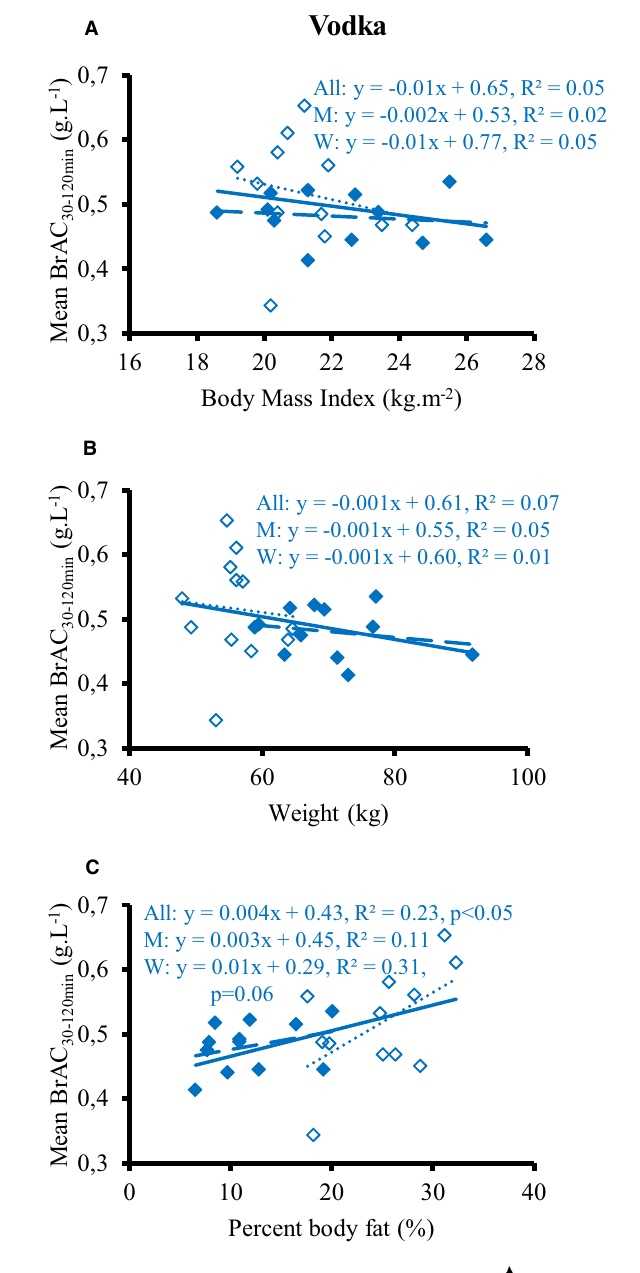
FIGURE 2 | Correlation between mean BrAC 30 − 120min for 12 men ( , – – ) and 12 women ( 1 , ……) and body mass index (A) , weight (B) , and percent body fat (C) after drinking vodka (left panel) and vodka + sugar (right panel).